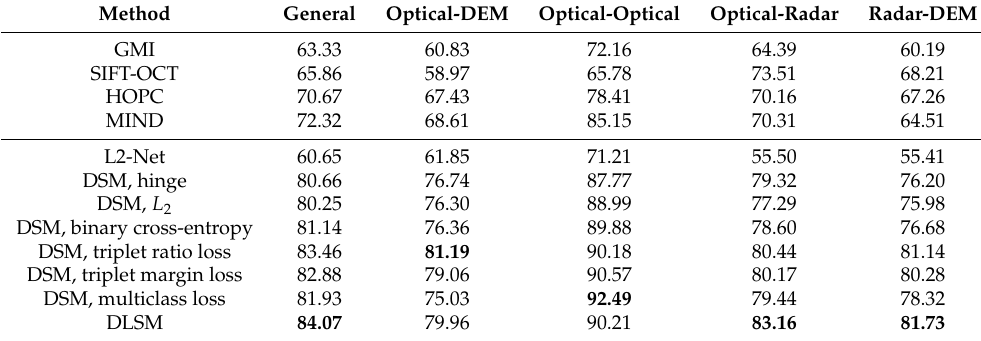
Table 1. Area Under the Curve (AUC) in % for SMs in comparison for general and particular registration cases. The best AUC in each registration case is marked in